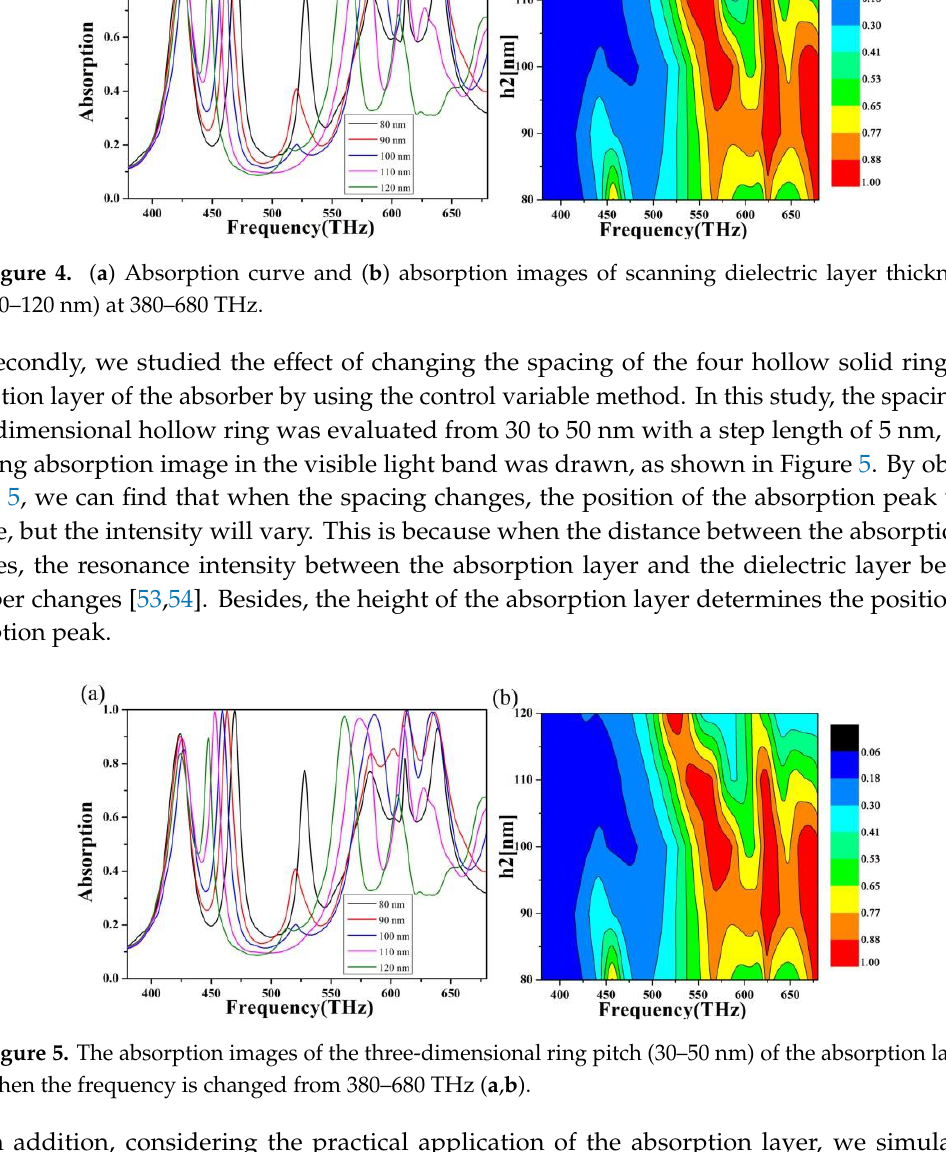
Figure 5. The absorption images of the three-dimensional ring pitch (30–50 nm) of the absorption layer when the frequency is changed from 380–680 THz ( a , b ).